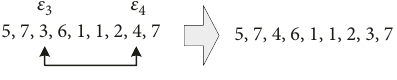
Figure 6: Chromosome